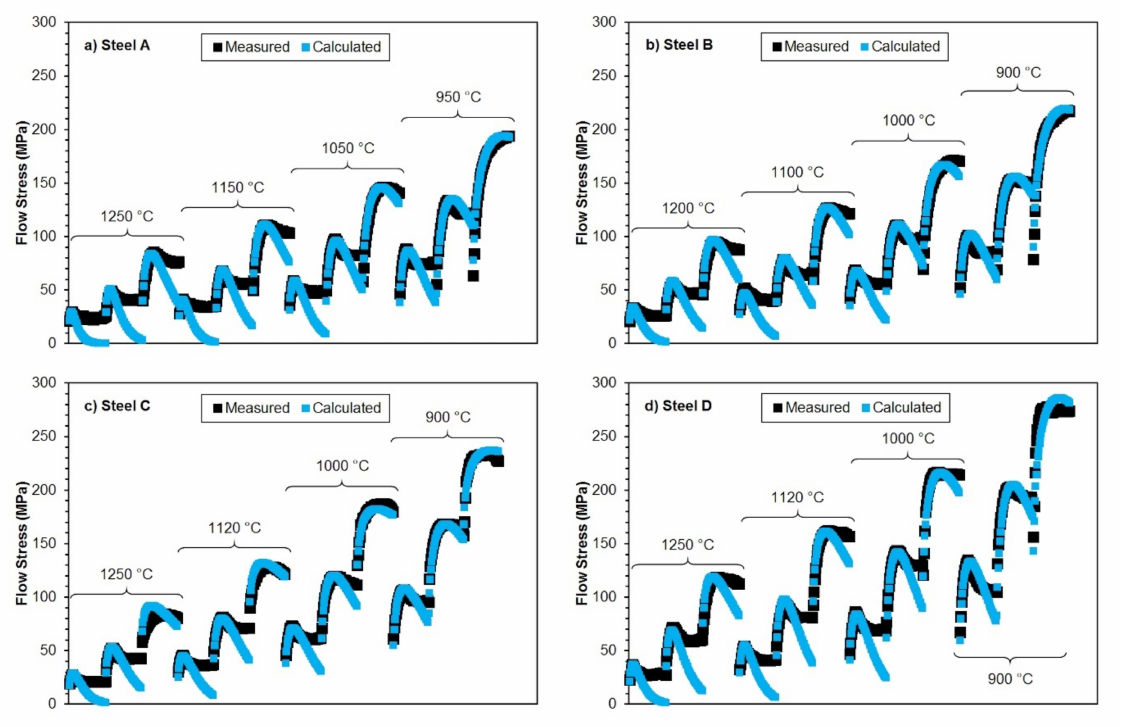
Figure 20. Comparison of measured (black points) and by Equation (14) predicted (blue points) individual flow stress curves of investigated steels: ( a ) steel A; ( b ) steel B; ( c ) steel C; ( d ) steel